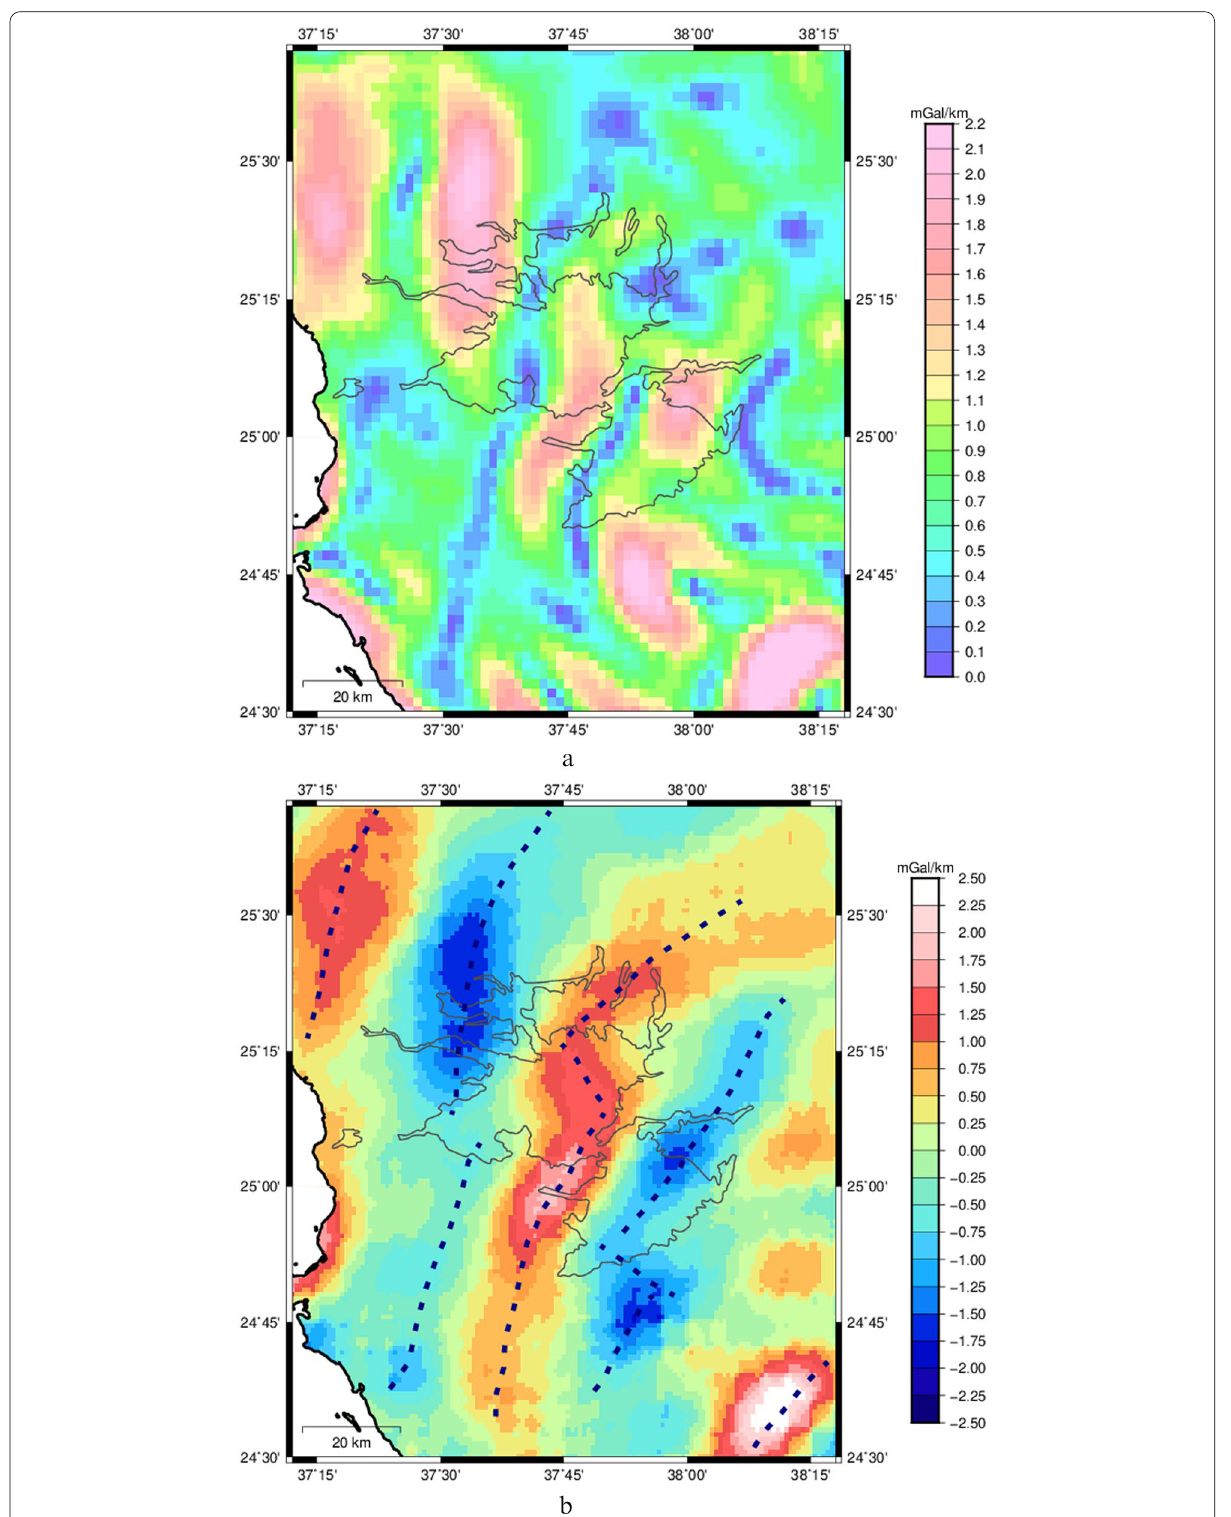
Fig. 6 a Magnitude of horizontal gradient. Maxima corresponding to boundaries represented by density contrasts. Values are in mGal/km. b NW– SE directional horizontal gradient to highlight NE–SW gravity trends represented by maxima and minima. Values are in mGal/km. These NE–SW trends correspond to the location of density contrast and interpreted to be inherited faults in the